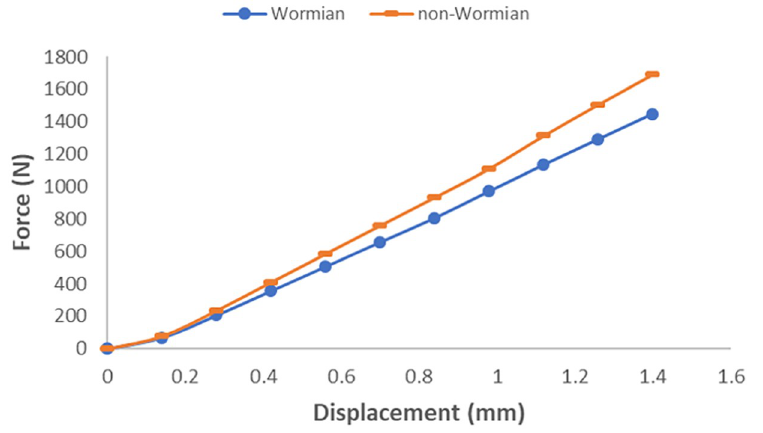
Fig 11. Load-displacement curve for the loading probe for parametric non-Wormian (dash) Wormian (circle) models.